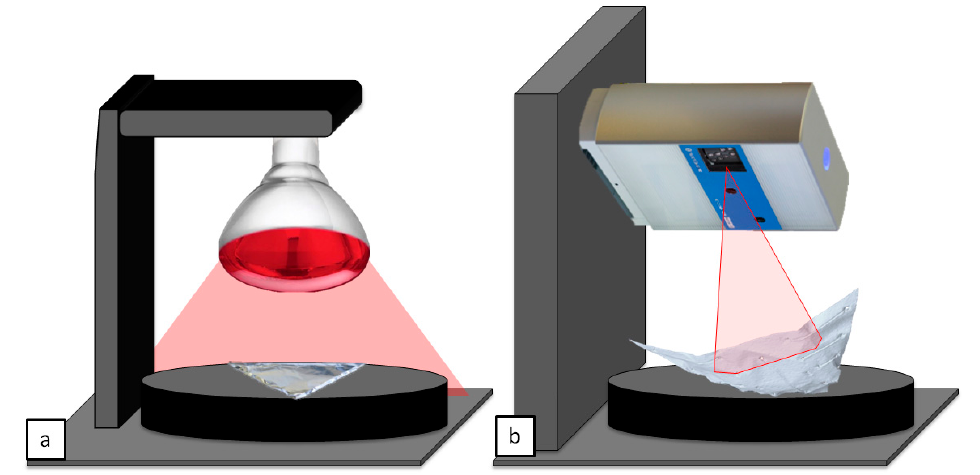
Figure 3. Heating ( a ) and reverse engineering ( b ) layouts.